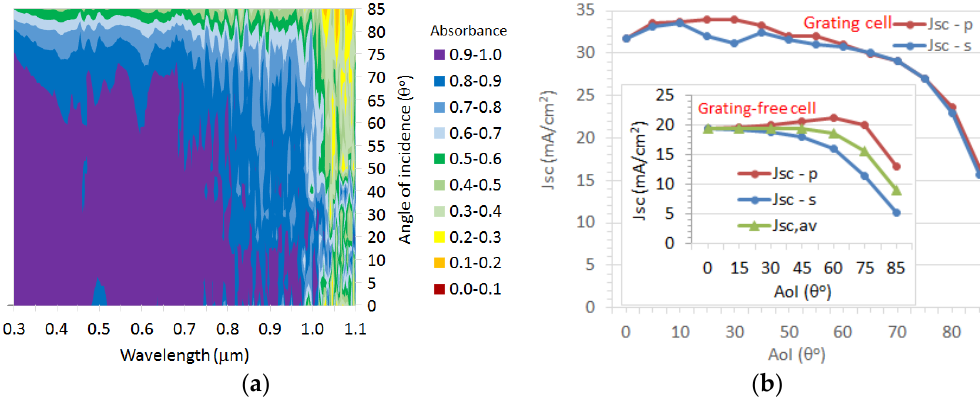
Figure 6. ( a ) Absorption spectra of the dual-grating cell (c-Si thickness = 2 μm) and ( b ) corresponding J SC of the cell as a function of angle of incidence (AoI) in the range 0°–85° in steps of 5° (inset shows the J SC of grating-free cell for p- and s-polarization and its average). The average absorption is more than 80% over a wide wavelength band. J SC is independent of polarization and is less influenced until the AoI reaches 70°, showing the omni-directionality of the nanocone grating structures.